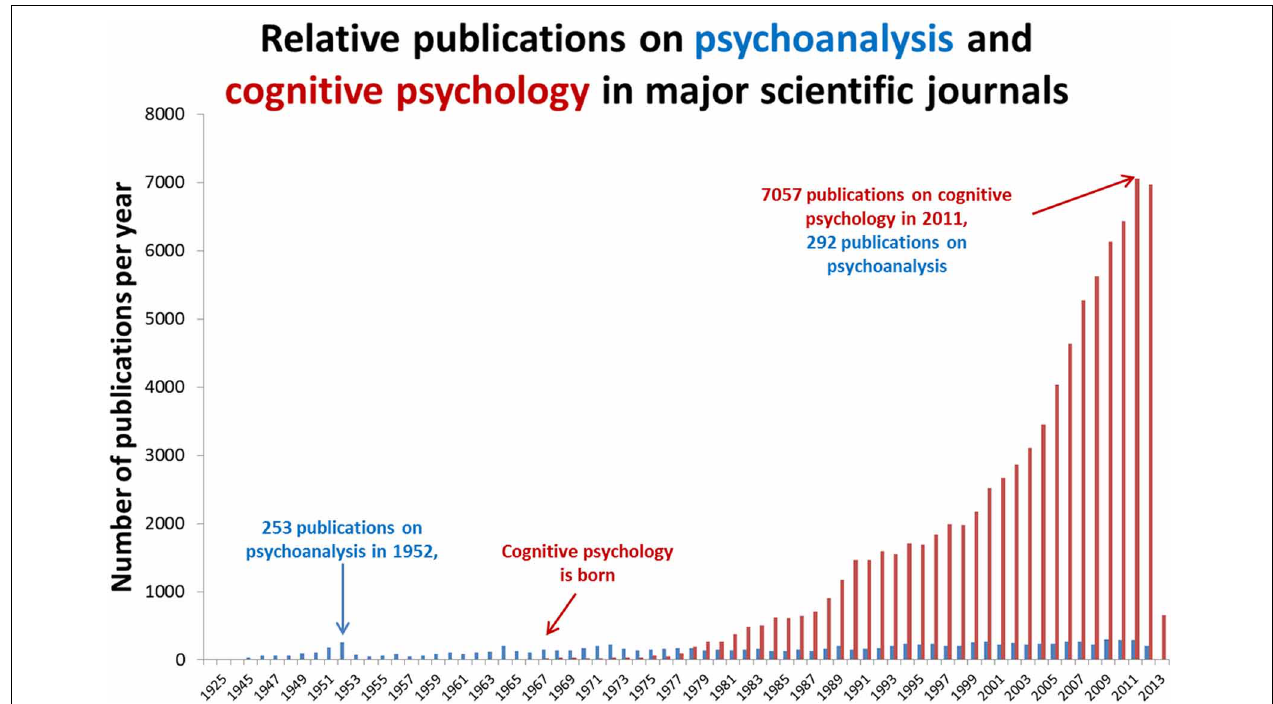
FIGURE 1 | Relative publications on psychoanalysis and cognitive psychology. Annual publications in major medical science journals referenced in the leading database, PubMed. Articles were retrieved by entering the search terms “psychoanalysis” and “cognitive psychology” in separate searches using the default search parameters of PubMed. It is worth noting that psychoanalysis has a different publication culture to